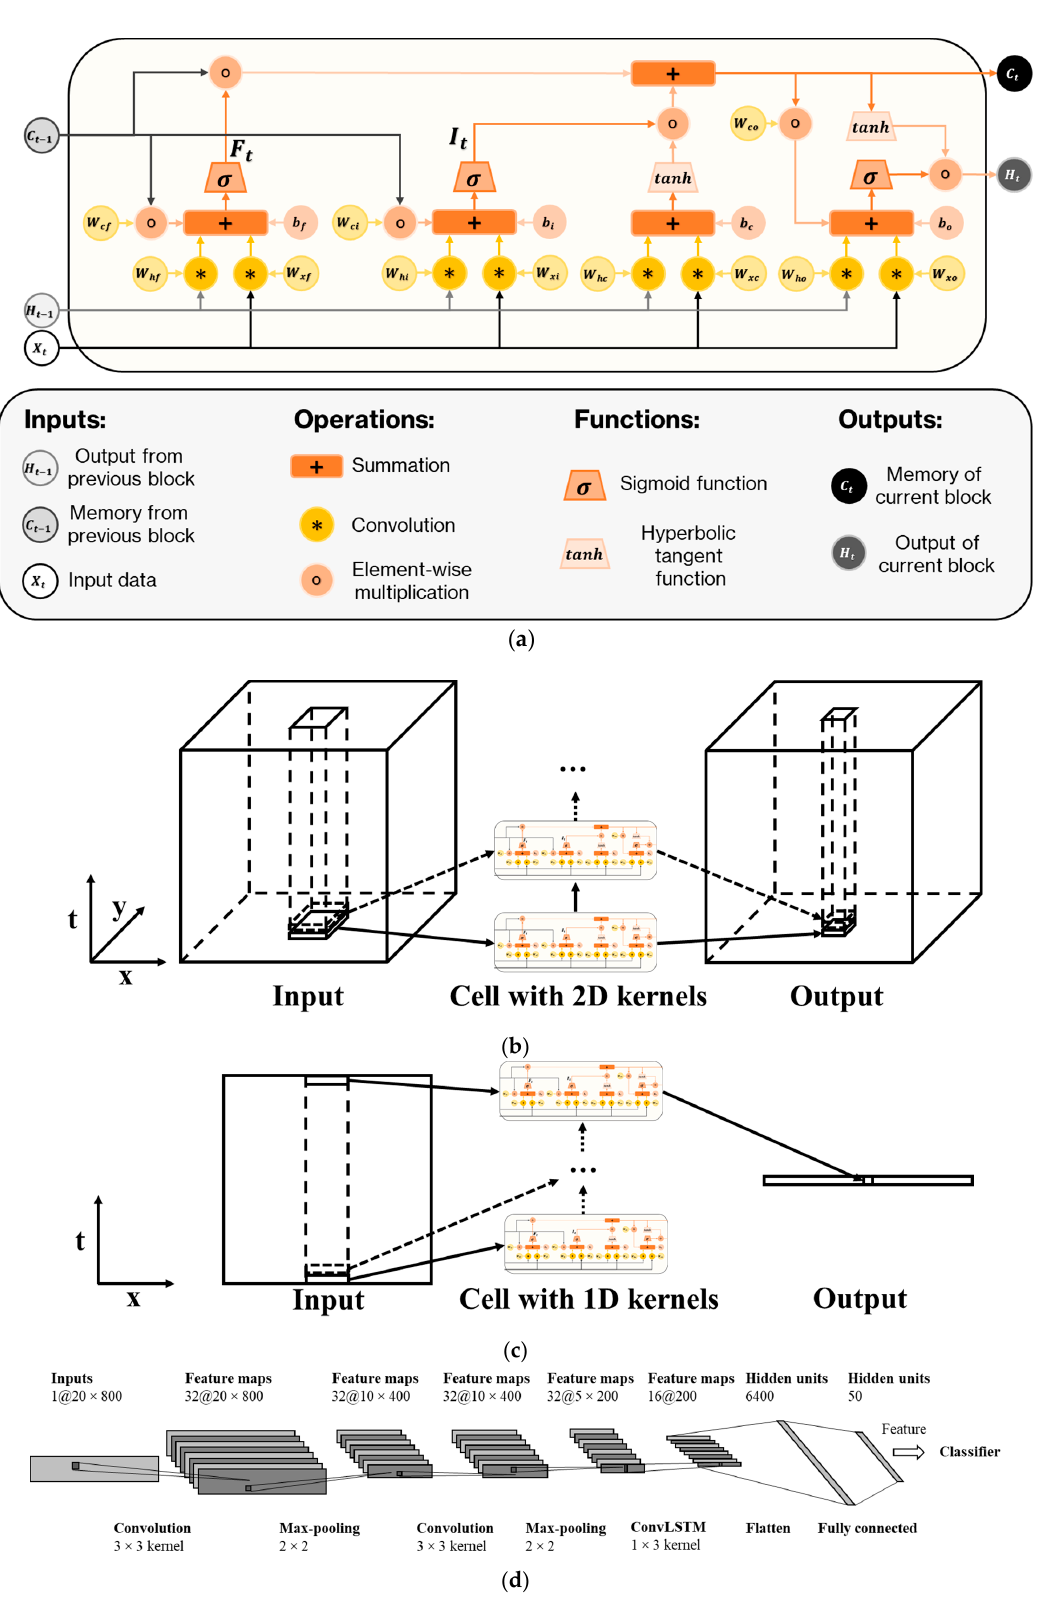
Figure 6. ( a ) Example of a convolutional long short time memory (ConvLSTM) cell. ( b ) Structure of the ConvLSTM that was proposed in [39]. ( c ) Structure of the ConvLSTM that was used in our method. ( d ) Structure of the proposed network. The size of the input data was 20 × 800. The network we propose had two 2D convolution layers—a 1D convolutional LSTM layer followed by a dense layer. In this network, the 2D convolution layers are used in the same way that 3D convolution layers are used in solving video classification problem. The convolution layer uses 3 × 3 kernels, followed by max-pooling layers with a scaling of 2. The convolution layers with a small reception field followed with pooling layers can extract low-level spatiotemporal features and reduce the number of parameters that need to be trained in the following layers. The output of the CNN layer is then fed into a 1D convolutional LSTM layer. Rather than returning the full sequence, the ConvLSTM layer is set to the mode where only the last output in the sequence is returned. Figure 6b,c illustrates the differences between the ConvLSTM structure proposed in [39] and the one that we employed in our method. The dense layer immediately after the ConvLSTM layer has 64 hidden neurons. The proposed network structure is shown in Figure 6d. The total number of trainable parameters of the proposed network structure is 172,836. The total number of trainable parameters of Lenet-5 network with the same input is 1,027,026. First, we employed two CNN layers to automatically define and extract features. Then, by adding a convolutional LSTM layer, the temporal structure of the falling process could be learned by the network.